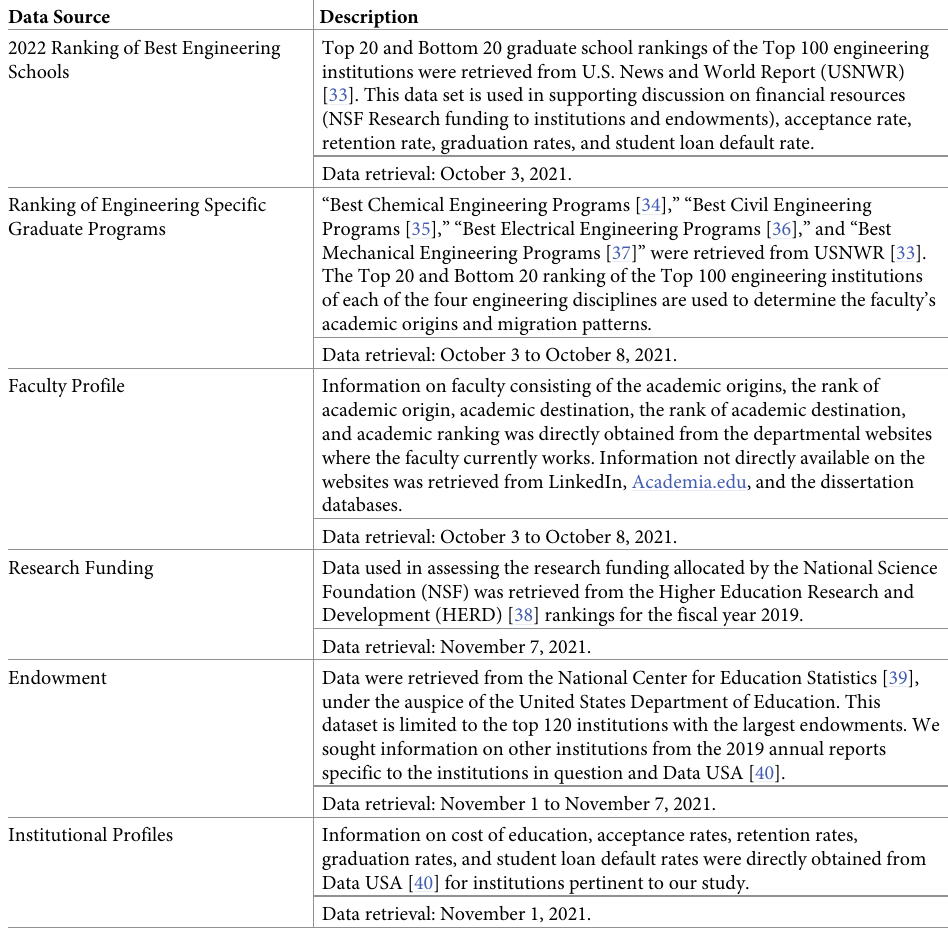
Table 1. Summary of data sources used for the